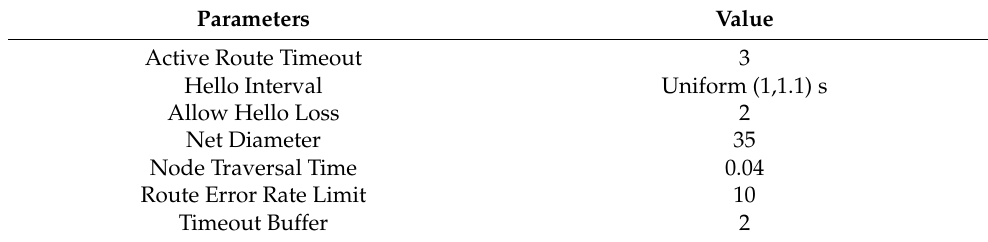
Table 3. AODV parameters used in the simulations.